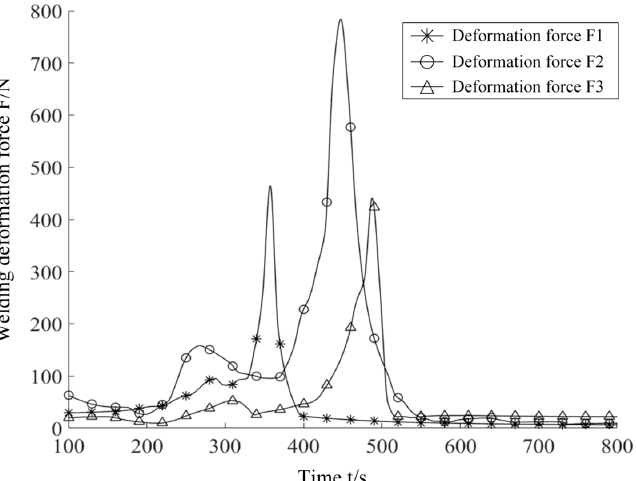
Figure 7. Variation curve of welding deformation reaction force of left crossbeam: F1 is the welding deformation force of the forward measurement points in the left crossbeam; F2 is the welding deformation force of the middle measurement points in the left crossbeam; F3 is the welding deformation force of the rear measurement points in the left